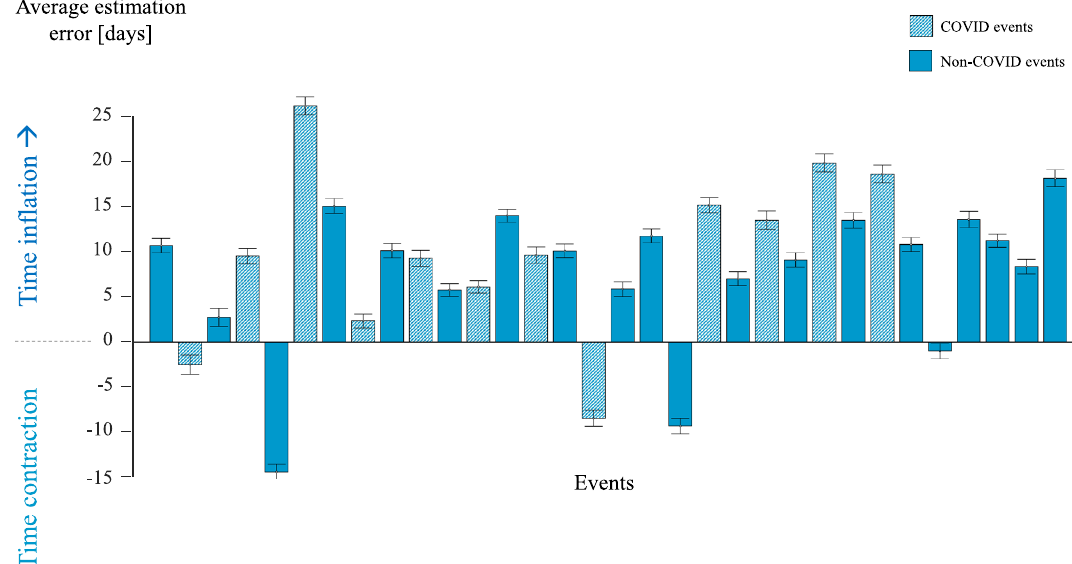
Figure 1. Average estimation errors for the 32 events included in the first stage of the experiment. Errors were calculated as subjective time estimations minus the objective times. Hence, positive values represent an inflated estimation and negative values represent contracted estimation, relative to the objective time. values (subjective minus objective time) and compared COVID and non-COVID events. Findings showed a significant difference between the two types of events, with COVID events experienced as more recent than the